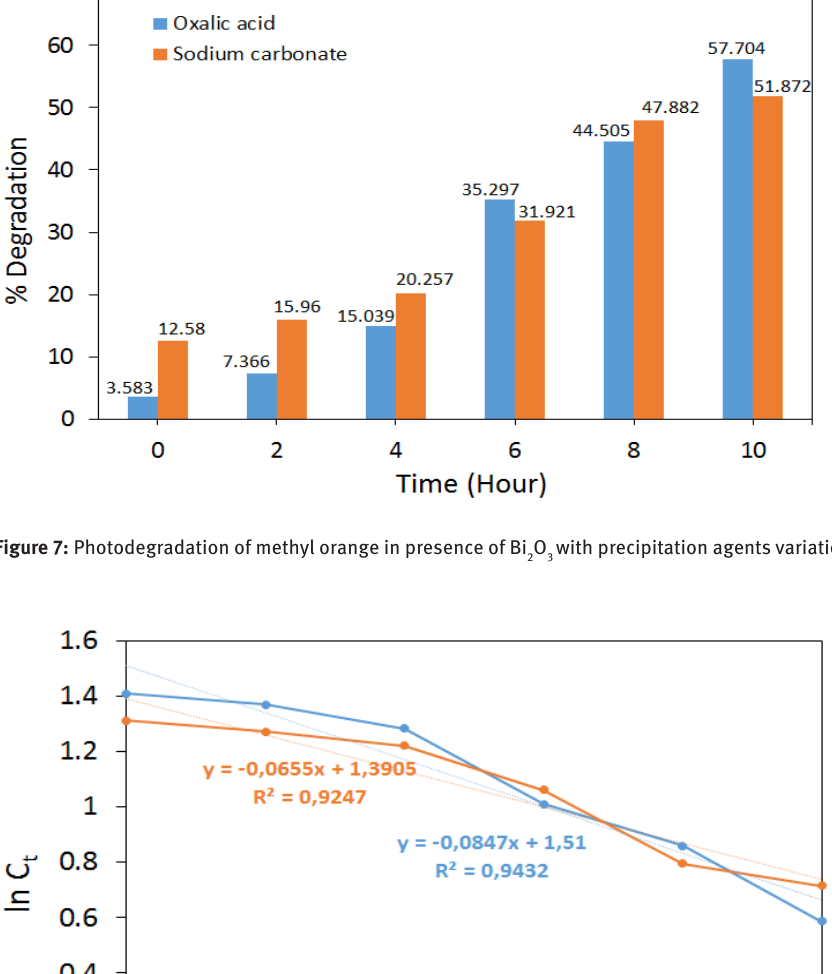
Figure 8: Kinetic linear simulation curves of the degradation of methyl orange in presence of bismuth oxide particles synthesized using H C O - and Na CO -pprecipitating 2 2 4 2 3